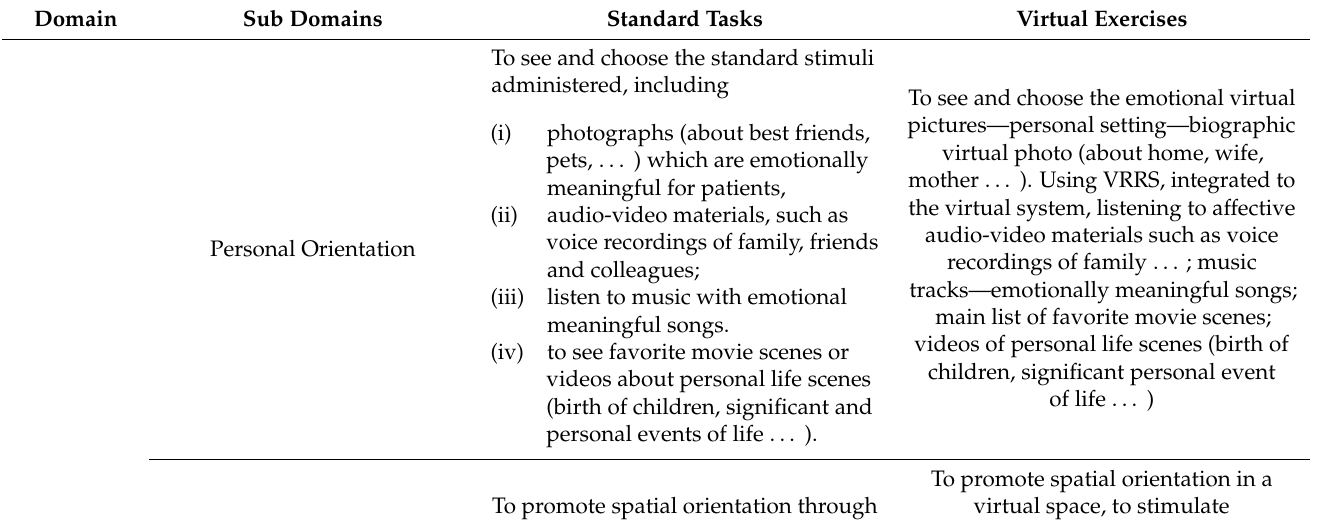
Table 3. Cognitive Training focused on visuo-executive processes, including both standard and virtual